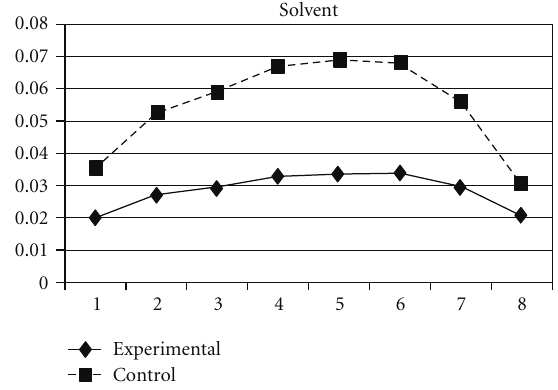
Figure 9: Growth trajectories of the experimental group (all partic- ipants) and control group using the item score of ketamine use as the outcome indicator.